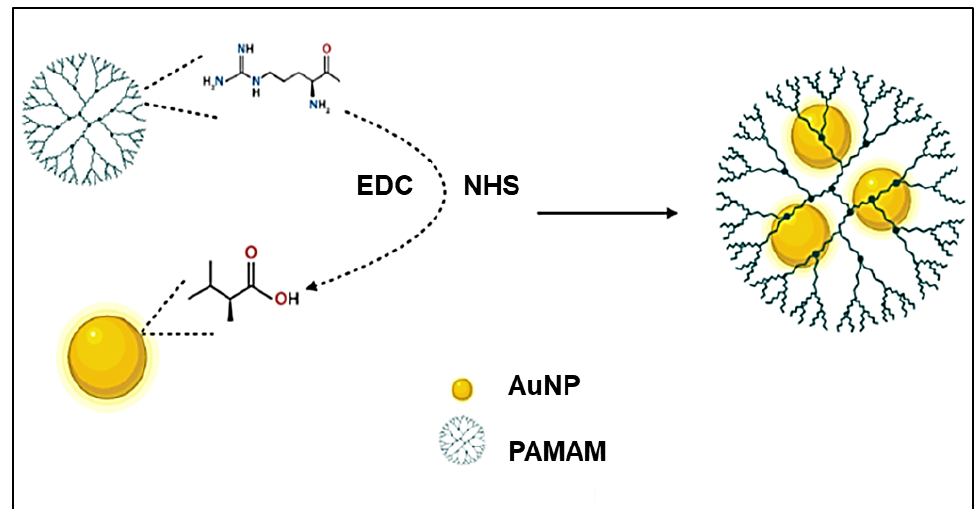
Figure 5. Schematic illustration showing Au–PAMAM NPs synthesized using carbodiimide chemistry (Created with BioRender.com, accessed 6 December 2022).